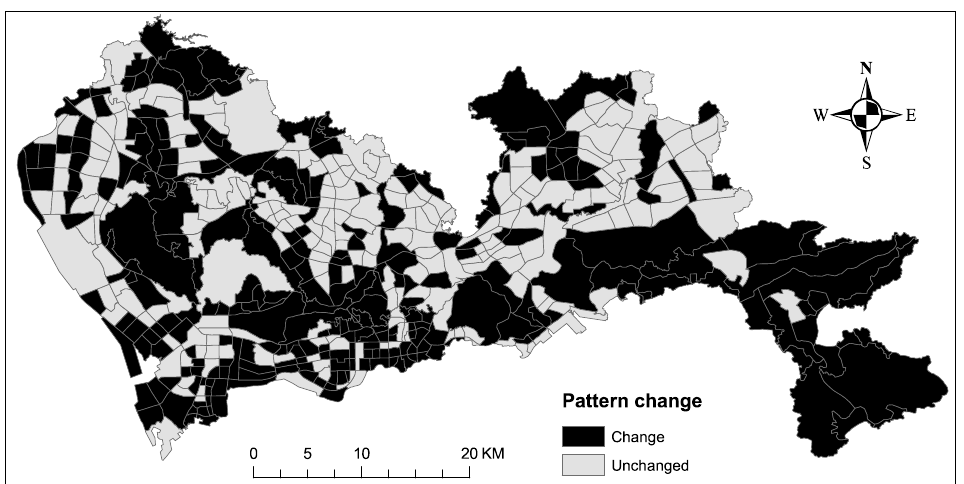
Figure 6. Spatial distribution of pattern changes in different periods.